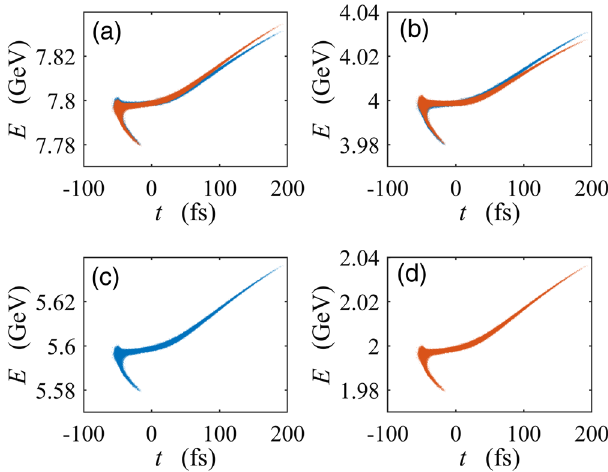
FIG. 9. Longitudinal phase space of the electron beam: (a) the first beam of case A (blue dot) and case B (red dot); (b) the second beam of case A (blue dot) and case B (red dot); (c) the third beam of case A; (d) the third beam of case